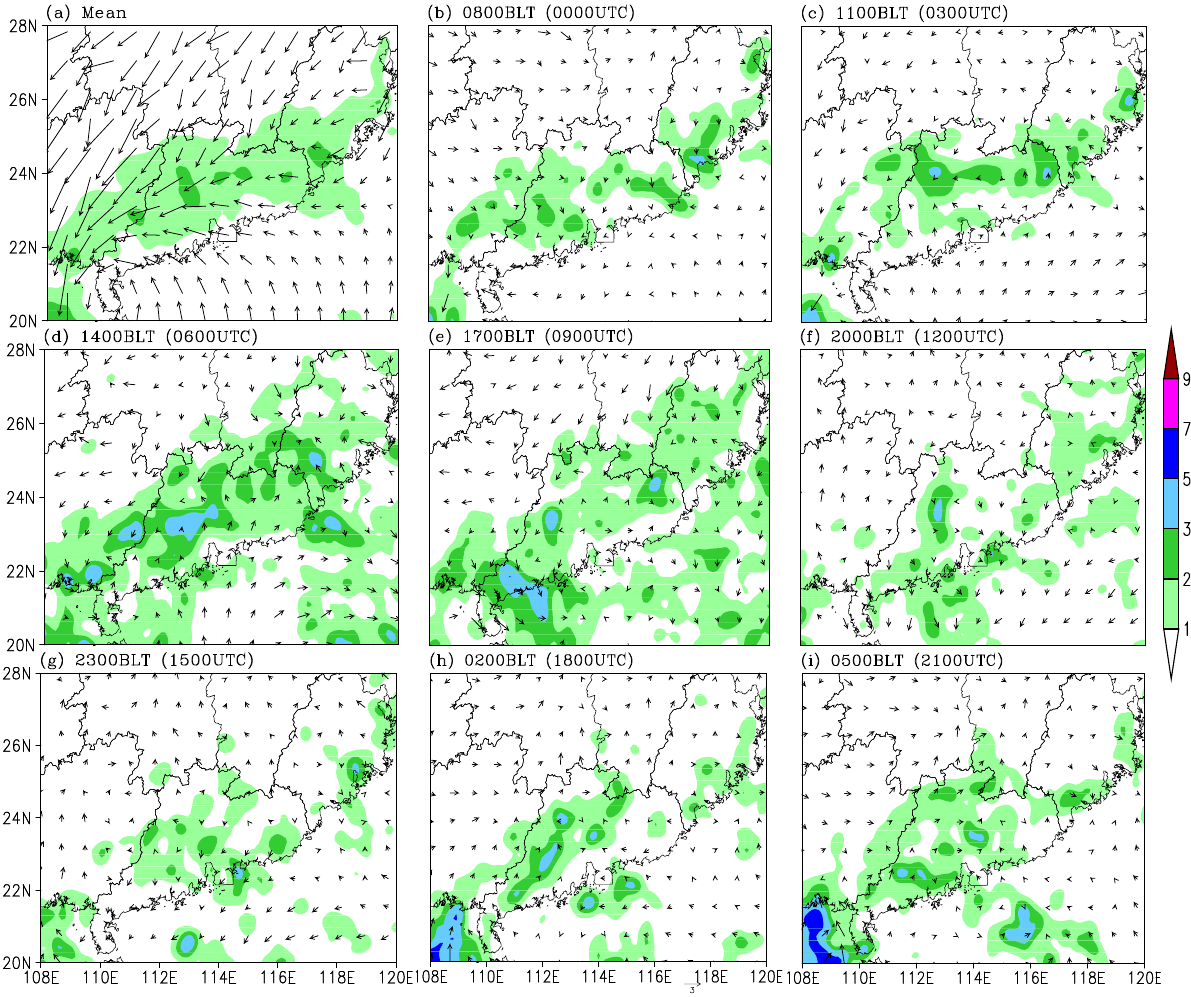
Figure 13. The results of Exp NLS for mean hourly rainfall (shaded, unit: mm) and 10-m wind (contours, unit: m·s –1 ) ( a ) and the diurnal evolution of rainfall intensity (shadings, unit: mm·h –1 ) and anomalous 10-m wind (vectors, unit: m·s –1 ) at ( b ) 0800 BLT, ( c ) 1100 BLT, ( d ) 1400 BLT, ( e ) 1700 BLT, ( f ) 2000 BLT, ( g ) 2300 BLT, ( h ) 0200 BLT and ( i ) 0500